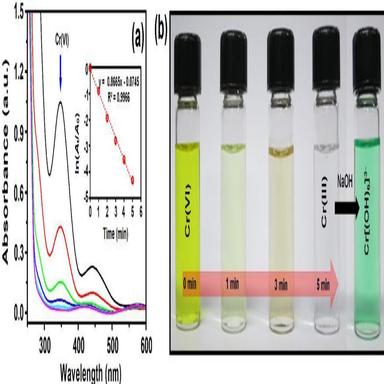
(a) Time-dependent UV/Vis spectra associated with the reduction of Cr(VI) catalyzed in the presence of RuePd@CFAC by FA and (b) The photograph of color change during the Cr(VI) reduction at different time intervals and formation of (3 (green color) after the addition of aqueous NaOH. (For interpretation of the references to color in this figure legend, the reader is referred to the Web version of this article.)